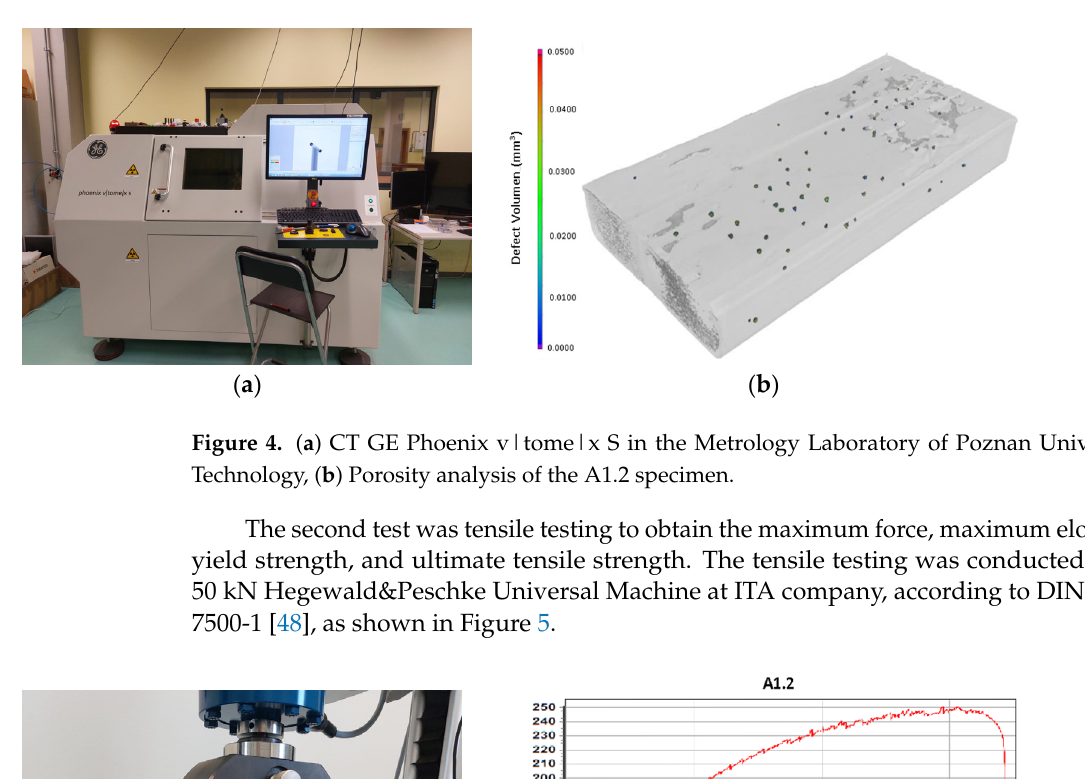
Figure 3. Tensile specimen layout according EN ISO 6892-1:2016.